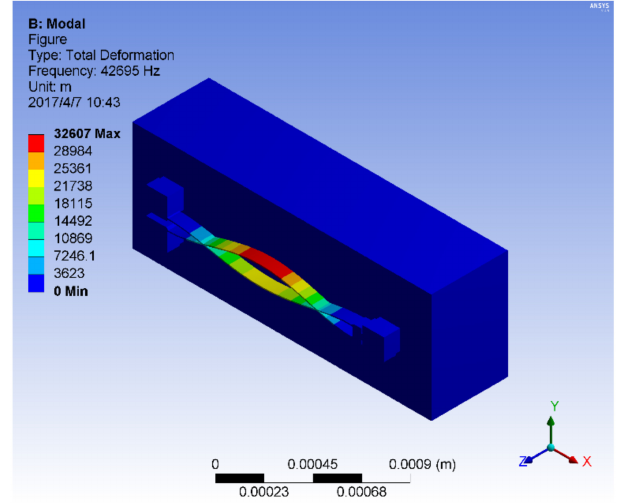
Figure 3. The first differential vibration mode of the double-ended tuning fork